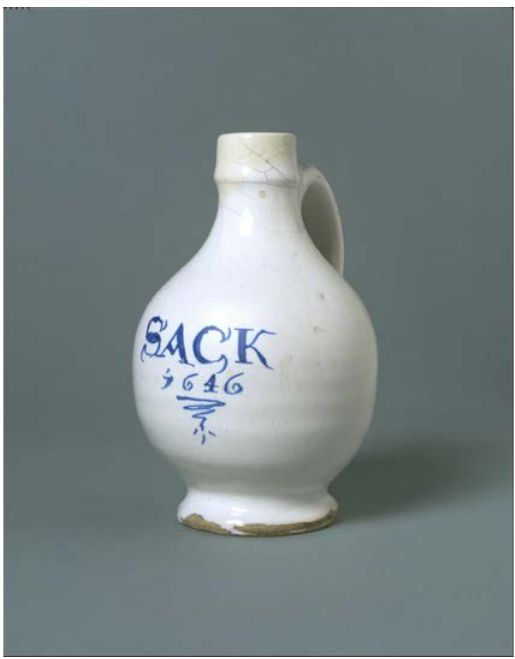
Figure 1 – Victoria and Albert Museum, London, museum no.